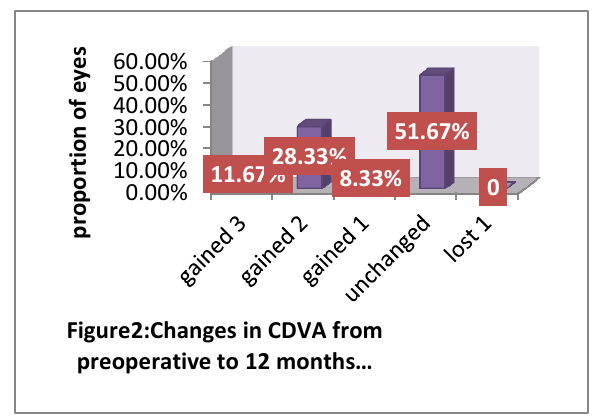
Figure2:Changes in CDVA from preoperative to 12 months